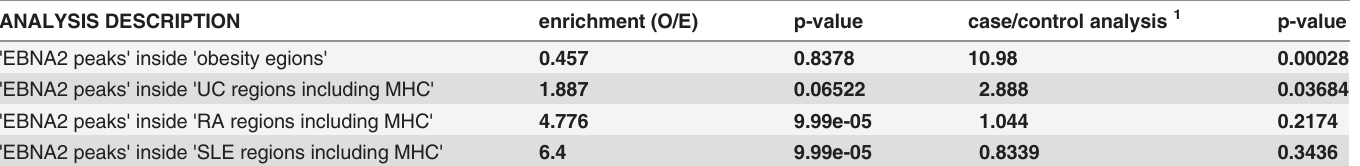
Table 3. EBNA2 overlap with genomic region associated to other disorders.